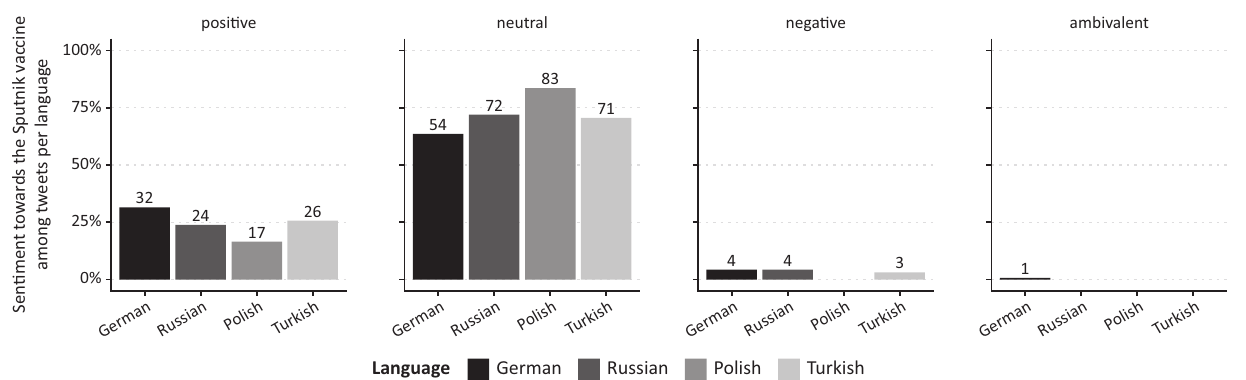
Figure 5. Sentiments towards the Sputnik vaccine. Notes: The base for each language is the number of tweets that mention the Sputnik vaccine; n = 1,504, German ( n = 1,060), Russian ( n = 368), Polish ( n = 18), and Turkish ( n = 58); no statistically significant association ( p =